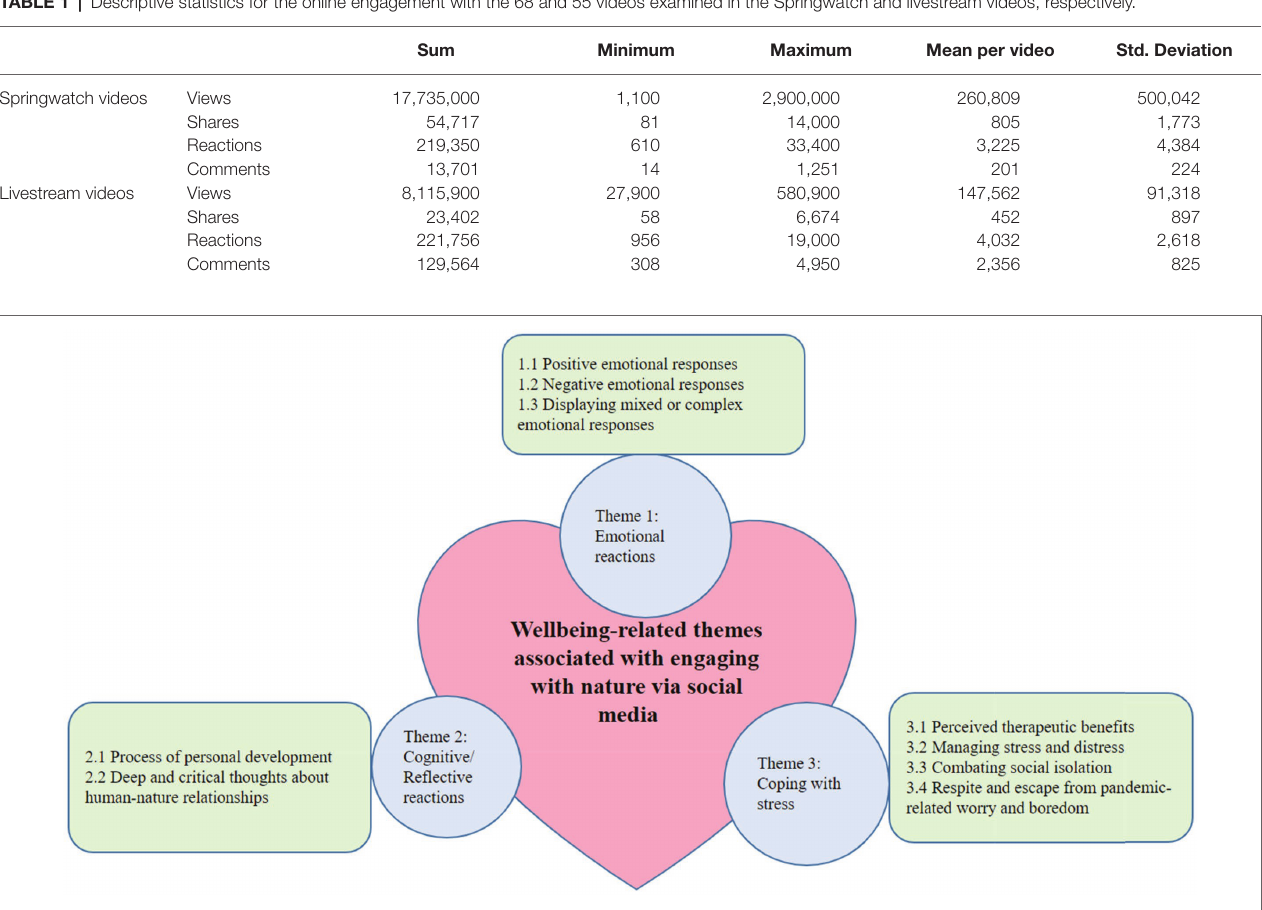
FIGURE 1 | Thematic map of wellbeing-related themes associated with engaging with nature via social media during